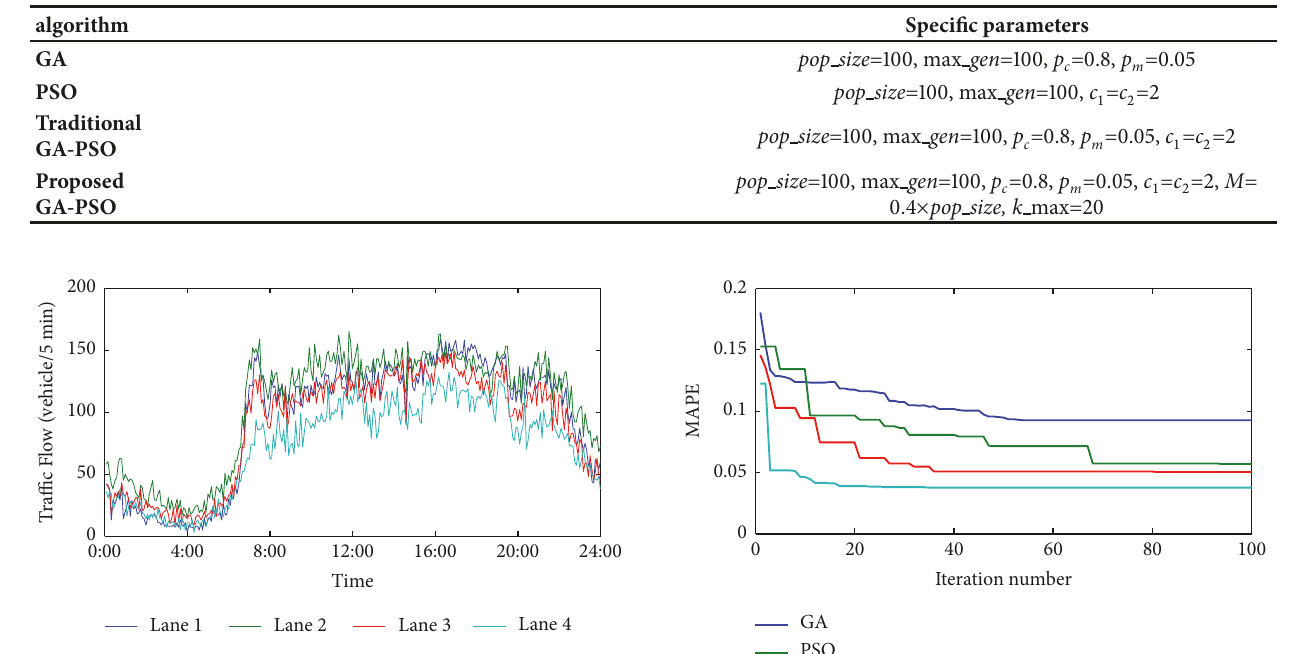
Figure 7: Traffic flow data of different lanes at the same detection cross section.